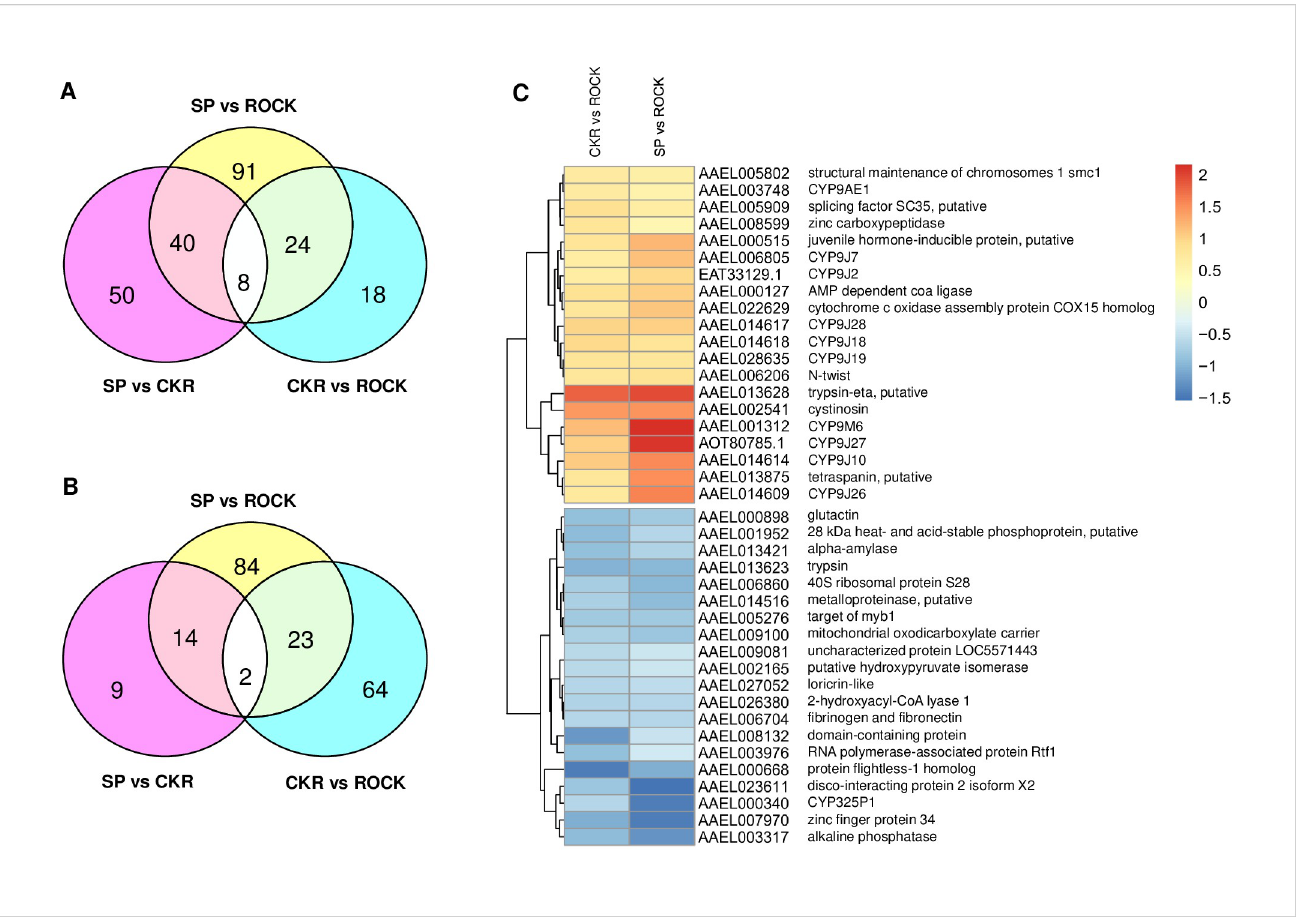
Fig 4. Proteins that were significantly up- or down-regulated between two strains. A: Venn diagram of the numbers of proteins that are significantly up-regulated (p � 0.05) between two strains; B: Venn diagram of the number of genes that are down-regulated (p � 0.05) between two strains; C: Heat map of the top 20 most differentially expressed proteins (based on CKR vs. ROCK comparison, but all genes shown were also differentially expressed in SP relative to ROCK). Heat maps were generated using PHEATMAP (https://www.rdocumentation.org/packages/pheatmap/versions/1.0.12/topics/pheatmap).